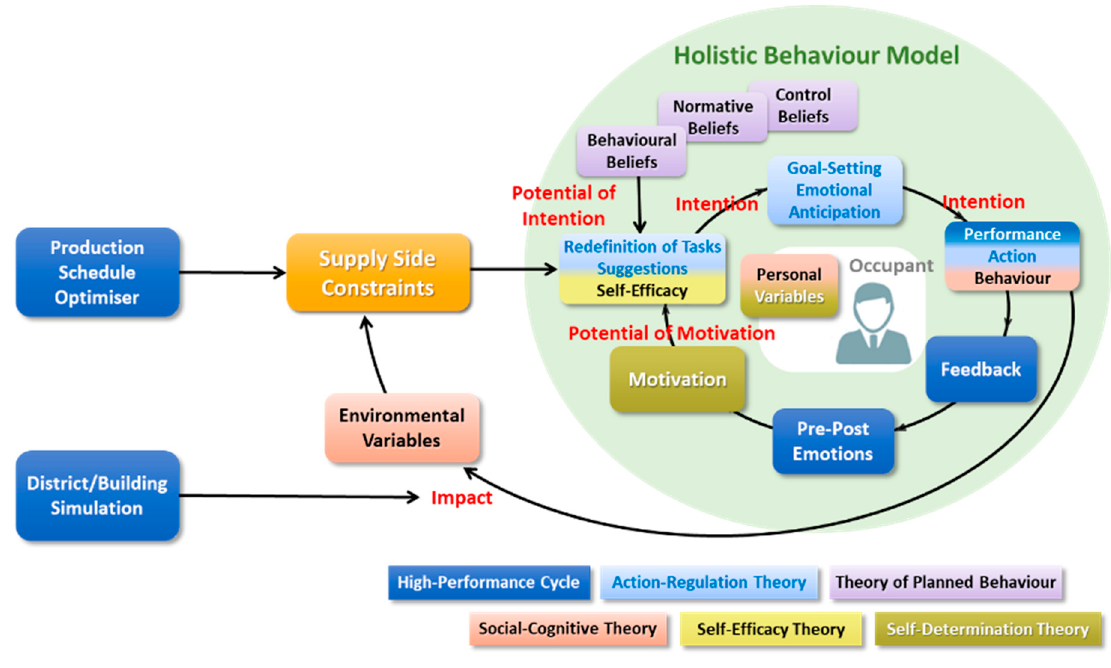
Figure 1. An integrated model of